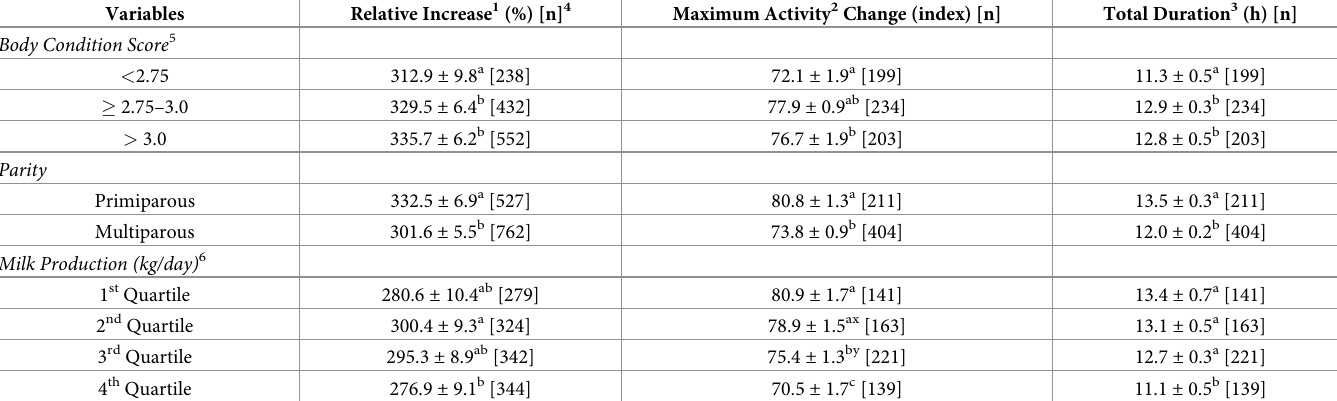
Table 1. Least squares means ± SEM for relative increase in activity (%), maximum activity change (index) and total duration (h) on body condition score, parity and milk production, in both Experiment 1 and Experiment 2.